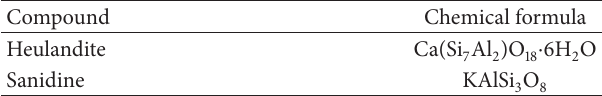
Table 1: Compounds identified by XRD.